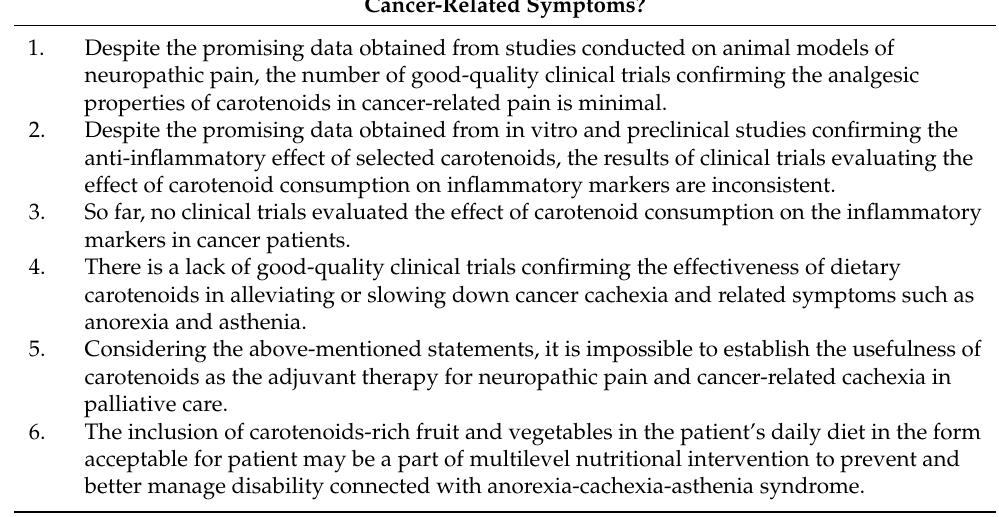
Table 3. Supplementation of carotenoids as the adjuvant treatment of cancer-related symptoms in palliative